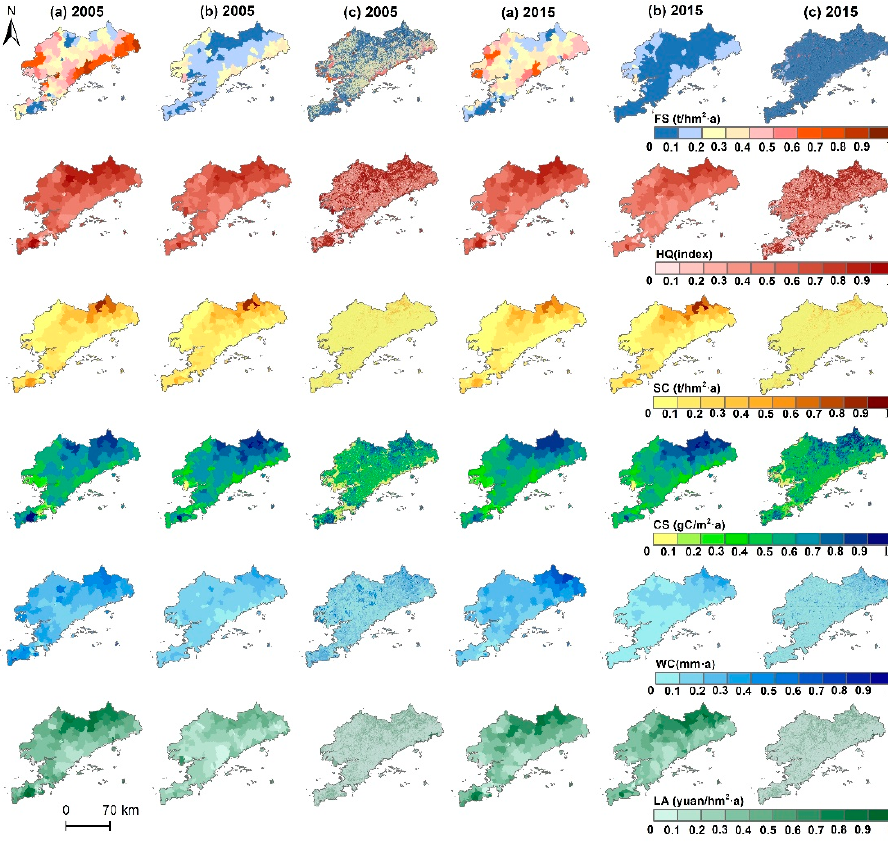
Figure 3. Spatial patterns of ESs in Dalian at three scales of analysis; ( a ) county scale, ( b ) watershed scale, ( c ) 1 km grid scale.